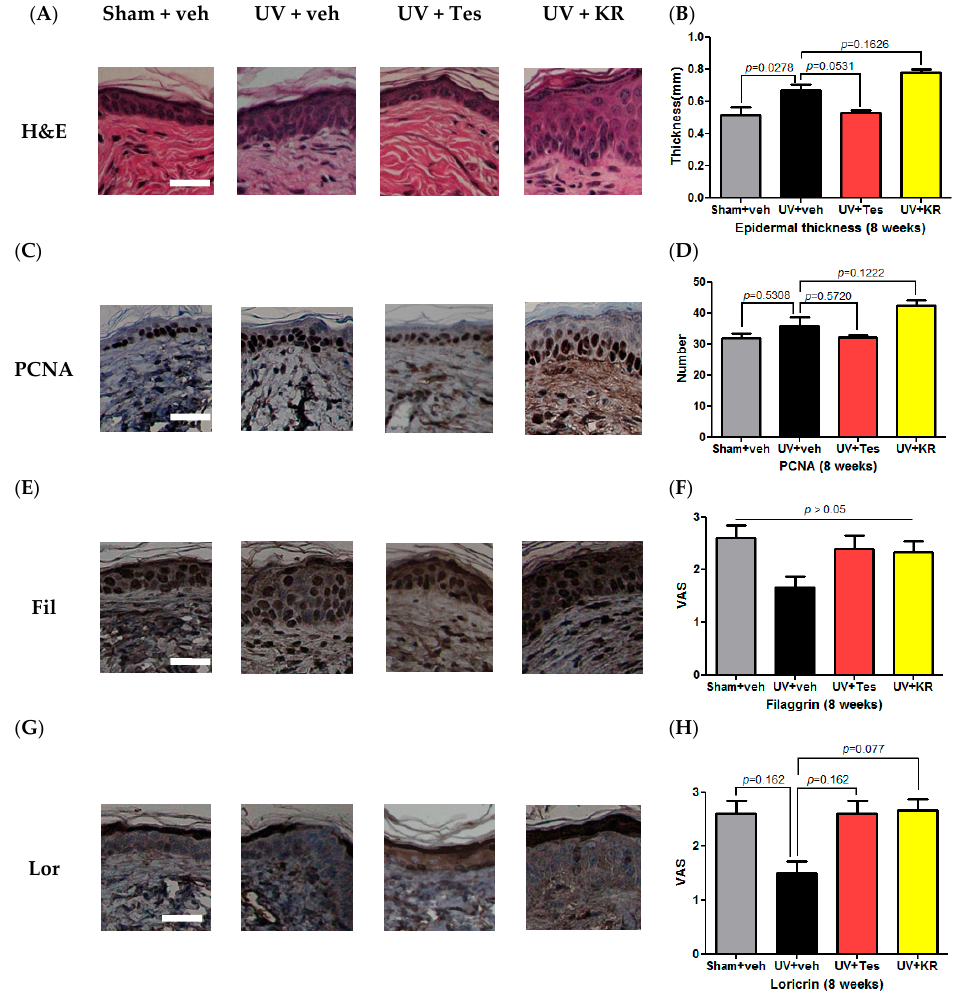
Figure 8. Effect of a mixture of extracts of Kochia scoparia and Rosa multiflora (KR) on epidermal proliferation and differentiation in photo-aging skin. To study the effects of KR on epidermal proliferation, epidermal thickness was evaluated by hematoxylin and eosin (H & E) staining ( A ); An 8-week course of UV radiation on 18-week-old mice significantly increased epidermal thickness. KR did not change epidermal thickness, whereas Tes showed a tendency to decrease it ( B ); Staining for proliferating cell nuclear antigen (PCNA) was also done to evaluate epidermal proliferation ( C ); UV radiation increased the number of PCNA stained keratinocytes. Neither KR nor Tes changed the number of stained keratinocytes ( D ); Epidermal differentiation represented by filaggrin and loricrin was evaluated after UV radiation accompanied with topical application of KR, vehicle, or tesaglitazar (Tes) for 8 weeks. Photoaging skin did not show any significant decrease in the expression of filaggrin and loricrin in the epidermis. Neither KR nor Tes affected filaggrin (Fil) or loricrin (Lor) expression in photoaging skin ( E – H ). The degree of staining was evaluated using a visual analogue scale (VAS) ranging from 0 to 3: 0—no staining, 1—mild staining, 2—moderate staining, 3—strong staining; Scale bars = 100 µm.